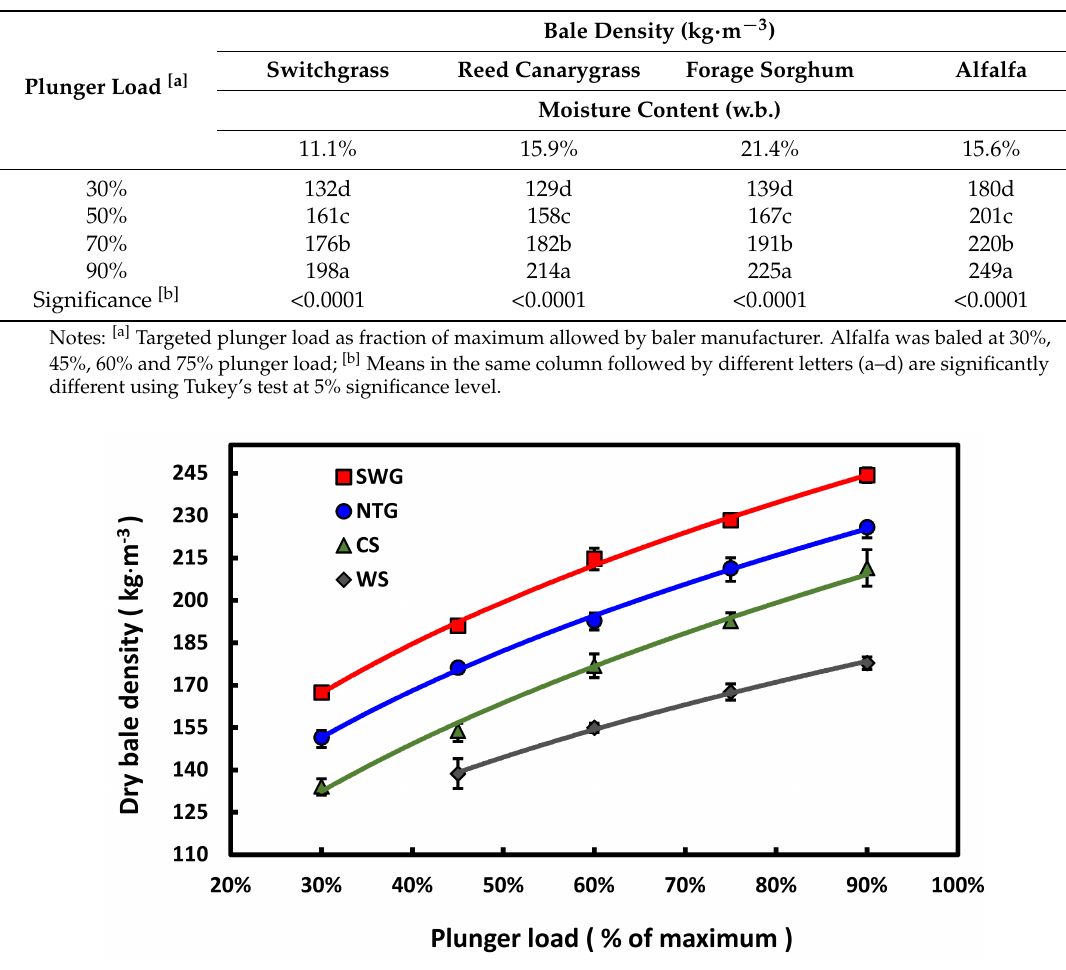
Table 2. Large square bale density (dry basis) as affected by plunger load (LSBr expr. No. 1, Table 1).